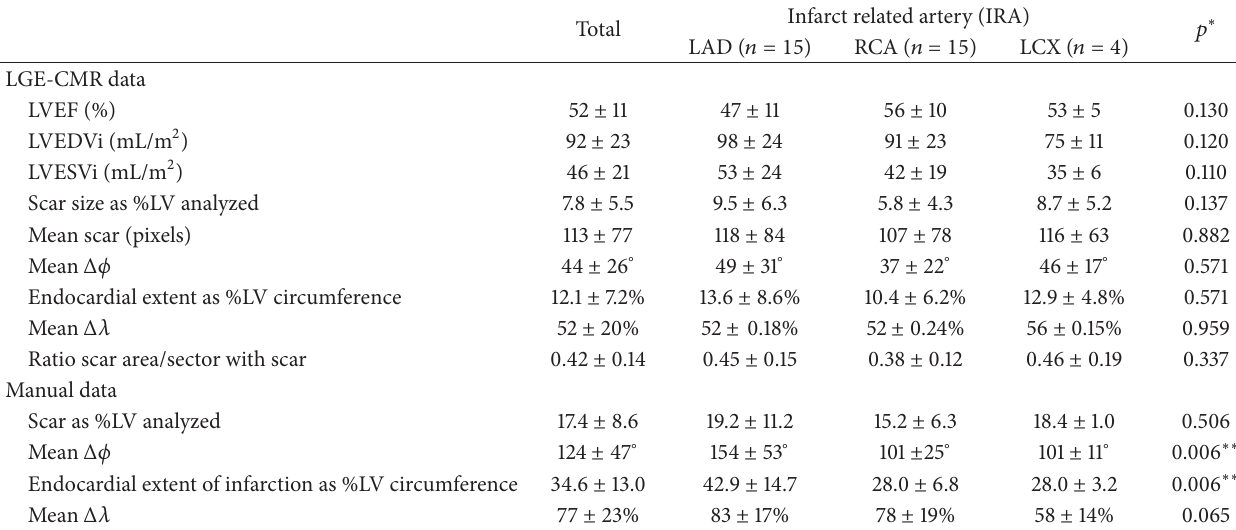
Table 2: Cardiacmagnetic resonancecharacteristics assessedoneyear following acute myocardial infarction treatedby primarypercutaneous coronary